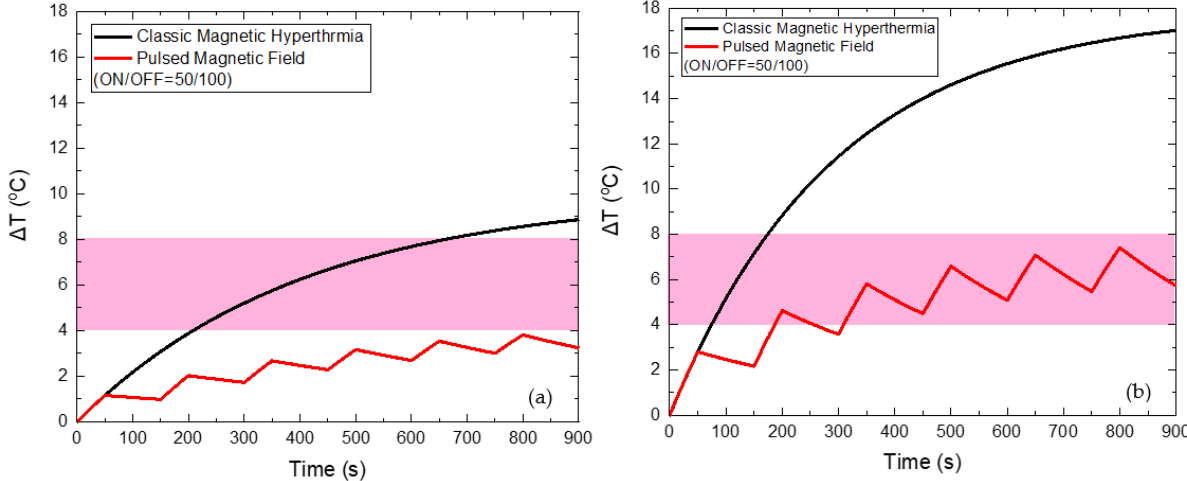
Figure 7. Temperature increase with time under 45 mT magnetic field after applying classic MPH (black) and PMF hyperthermia using ON/OFF = 50/100 s (red) for the HTP ( a ) and CTP ( b ) samples. When applying a PMF of 60 mT (Figure 8) with the optimum ON/OFF = 25/75 s, the reduction of the maximum temperature of HTP by 7.3 °C and of CTP by 15.2 °C is attained,